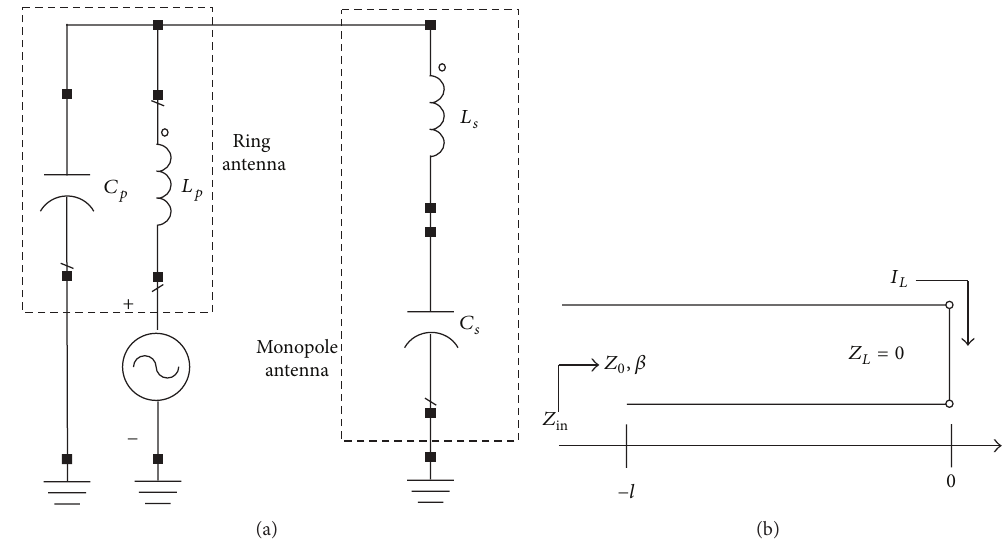
Figure 2: (a) IFA circuit model and (b) stub modeled as a short-circuited lossless transmission